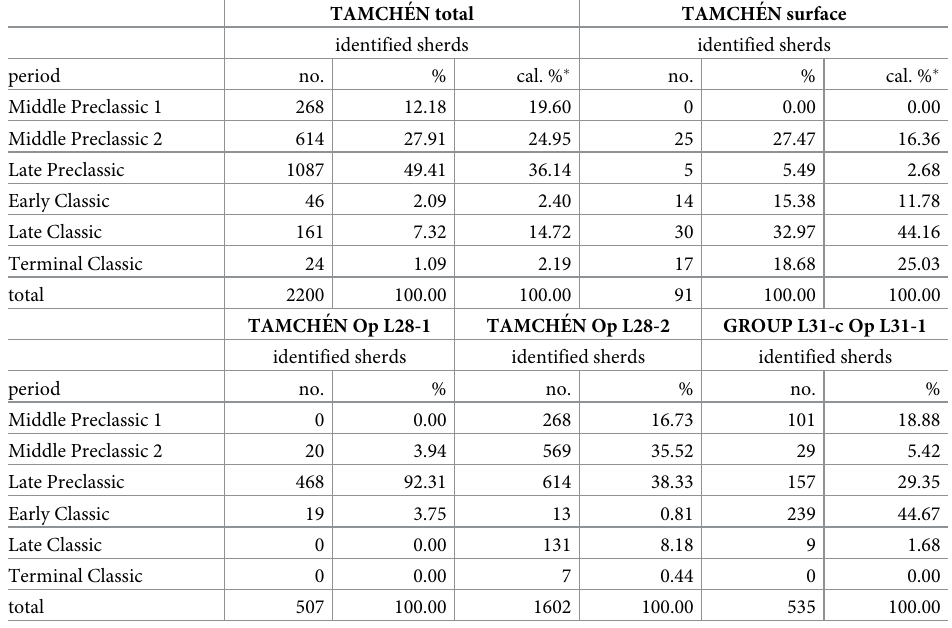
Table 3. Ceramic frequencies and percentages by period for Tamche´n, corresponding to all identifiable pieces (Tamche´n total) and surface collections only (Tamche´n surface), and for operations L28-1, L28-2 and